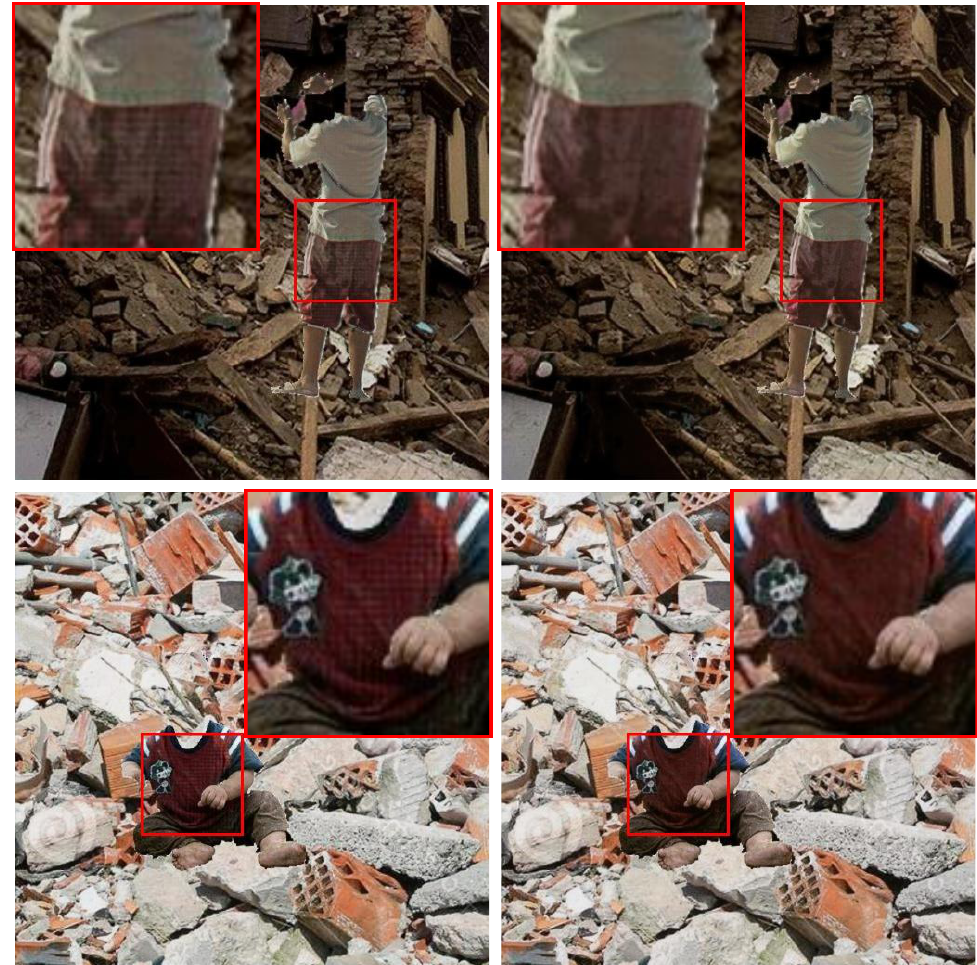
Figure 8. Visual comparison of using the global discriminator + attention modules and the full model. The first column shows images harmonized by the network without the local discriminator, on which some checkerboard artifacts are observed. The second column shows the corresponding images generated by the full harmonization network. We zoom in on some image areas for better